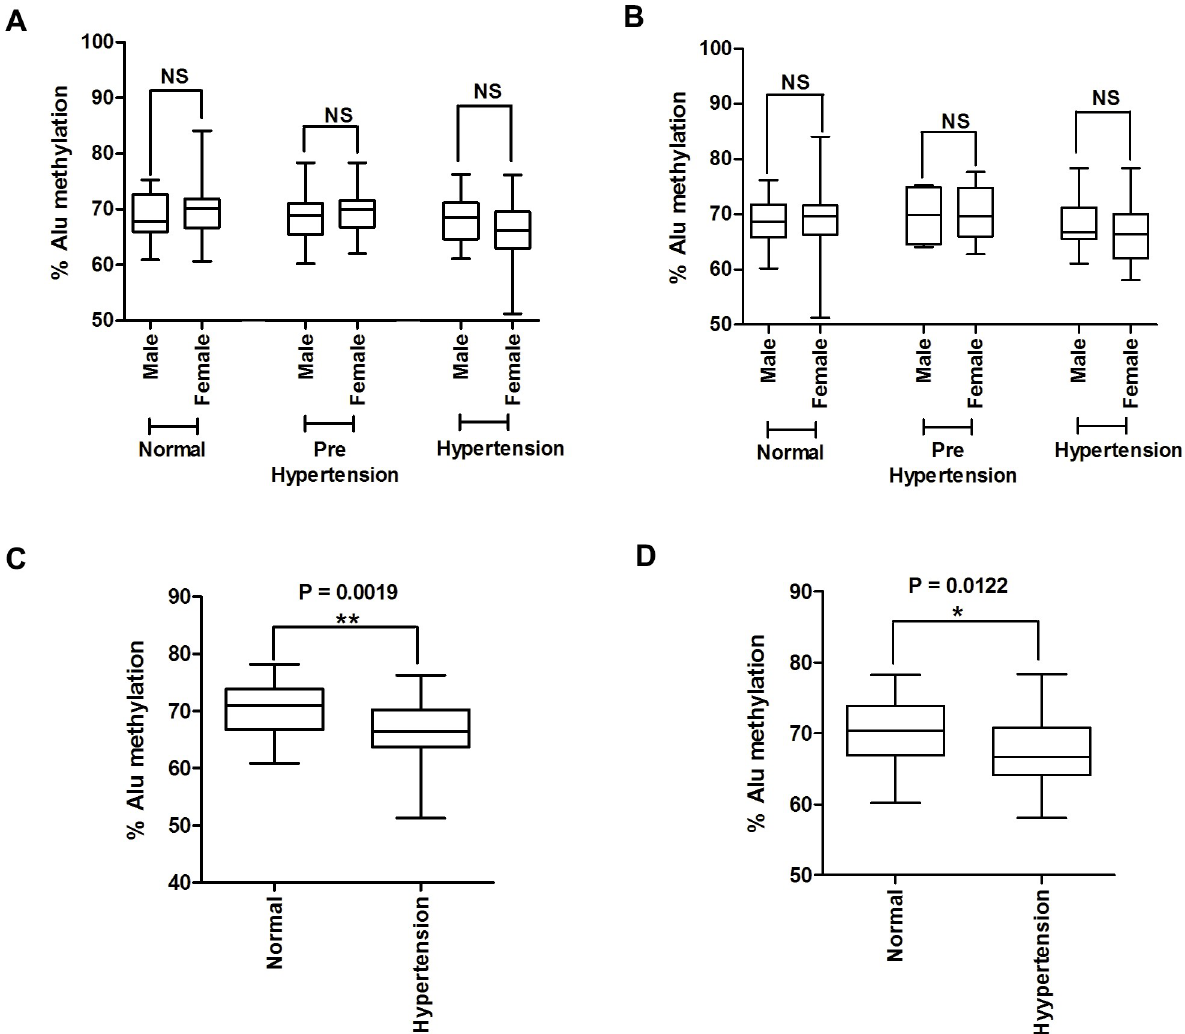
Fig 3. Alu methylation levels in Age- and sex-adjusted correlation. Comparisons of Alu methylation levels between males and females in the normal, prehypertension, and hypertension groups when grouping was performed based on the systolic pressure (A) and diastolic pressure indicators (B). The percentage of Alu methylation in age-matched pairs in normal samples and hypertension samples in groups based on both the systolic pressure (C) and diastolic pressure indicators (D). The boxes represent interquartile ranges (25th to 75th percentile), and median lines represent the 50th percentile. The whiskers represent the minimum and maximum values. � P < 0.05, �� P < 0.01 (Mann–Whitney